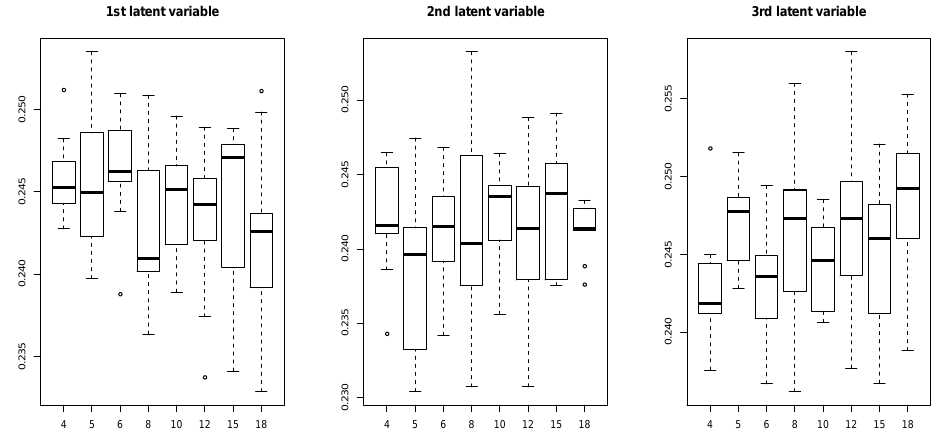
Figure 10. Boxplot of the first to third latent variable vectors attributed to the 81 samples. (cid:108) j (cid:109) (cid:16)(cid:108) (cid:109) (cid:17) k + 3 Horizontal axis: ,1 ≤ j , k ≤ 3. Averaged over 100 independent trials. 3 3 Up to the third latent vector, none is coincident with 9 classes defined in Equation (1).